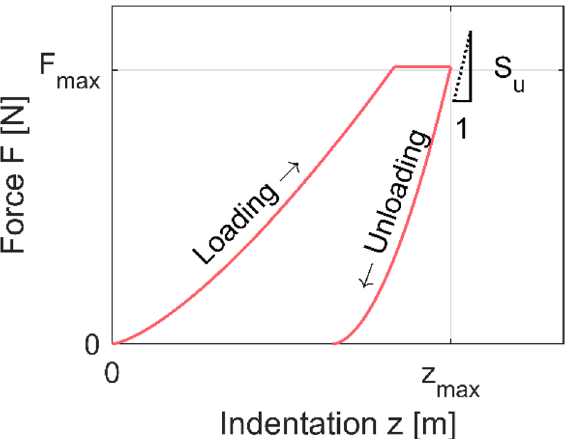
Figure 8. Force-Indentation depth plot illustrating the loading and unloading curve of the experiments. By determining the observed unloading slope S u , the indentation modulus M was calculated using Eq.